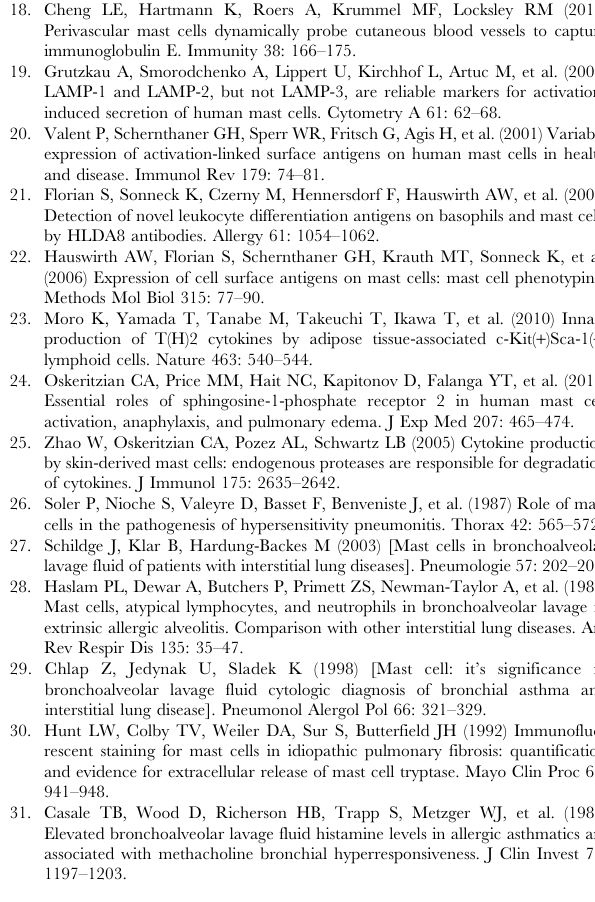
Table S1 The patients’ background. IIP; idiopathic inter- stitial pneumonia, CVD-ILD; collagen vascular disease associated interstitial lung disease, BALF; bronchoalveolar lavage fluid, NSS; nasal scratching specimen, *P= 0.0032 compared to control. Table S2 Profile of antibodies used in this